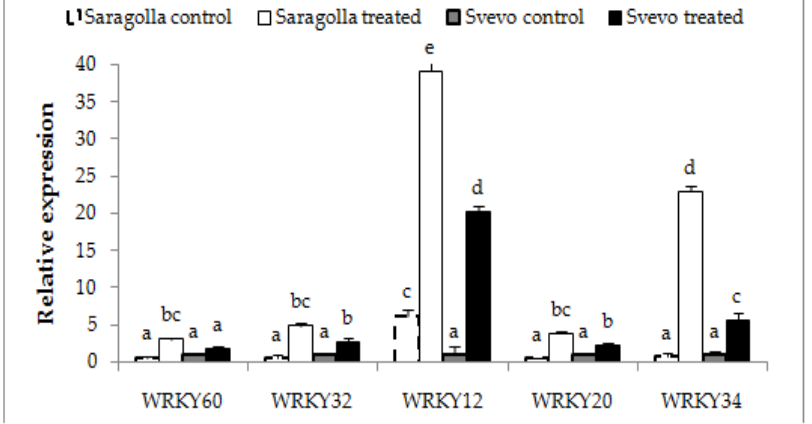
Figure 7. qRT-PCR analysis of WRKY genes in Svevo and Saragolla roots subjected to osmotic stress. Seven days-old Saragolla and Svevo seedlings were subjected to osmotic stress treatment for 5 days, by means of 18% PEG-6000 administration. At the end of the treatment, total RNA was extracted and the qRT-PCR analysis of relative expression of WRKY12 , WRKY20 , WRKY32 , WRKY34 and WRKY60 , performed as described in Section 4.7. The results of stressed roots are reported as fold changes with respect to non-stressed roots considered as unit. The results represent the mean values ± SD of three independent experiments. Statistical significance was attributed by one-way ANOVA test. Bars labeled with dissimilar letters are significantly different ( p < 0.05).